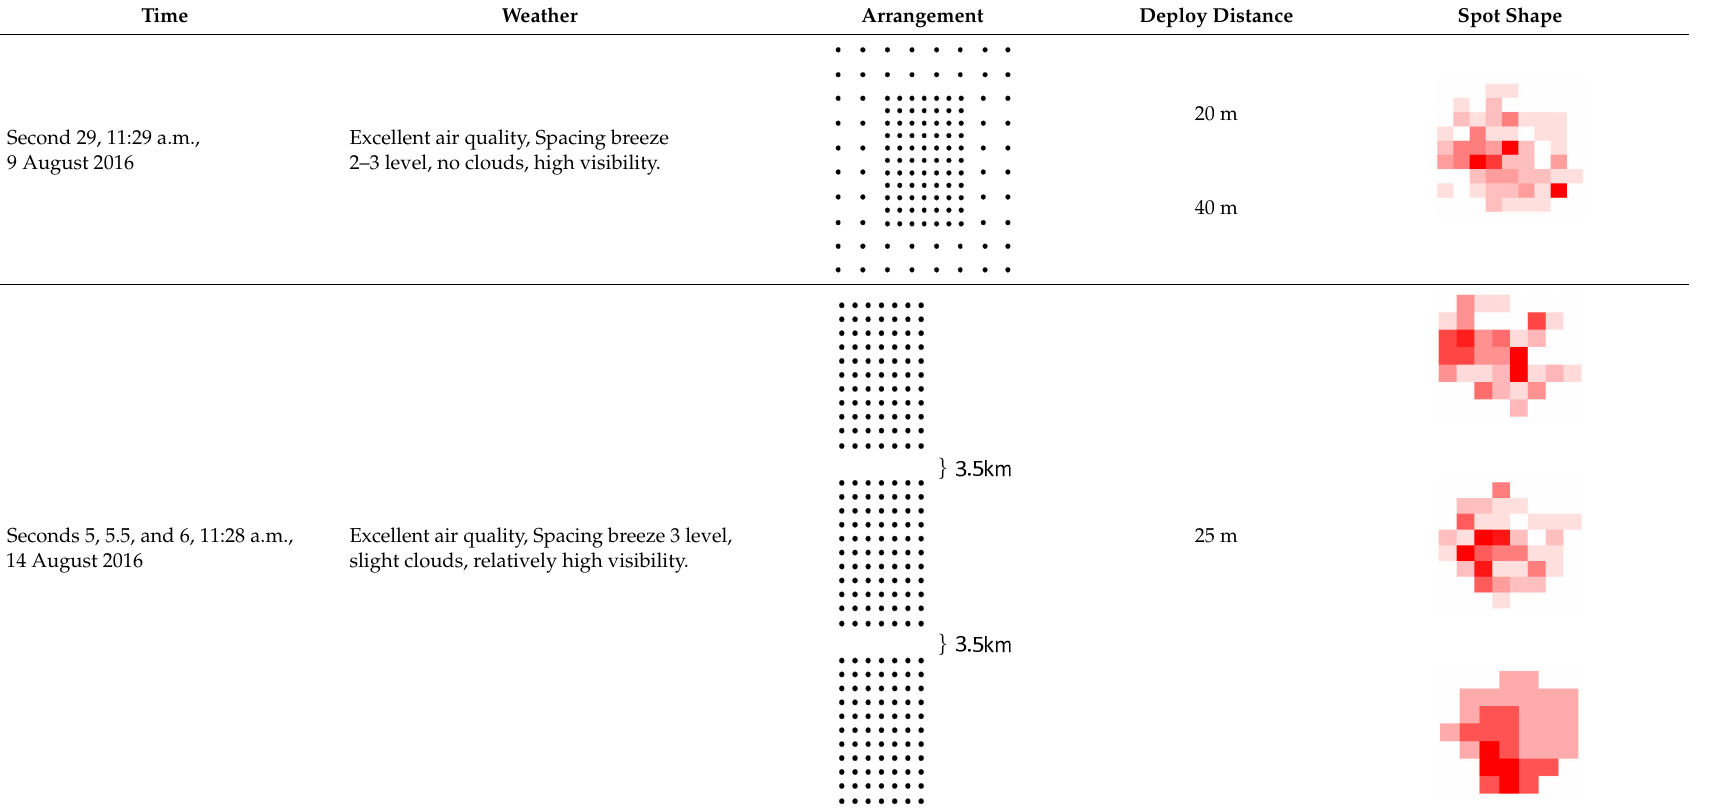
Table 4. Preview of altimeter calibration tests.